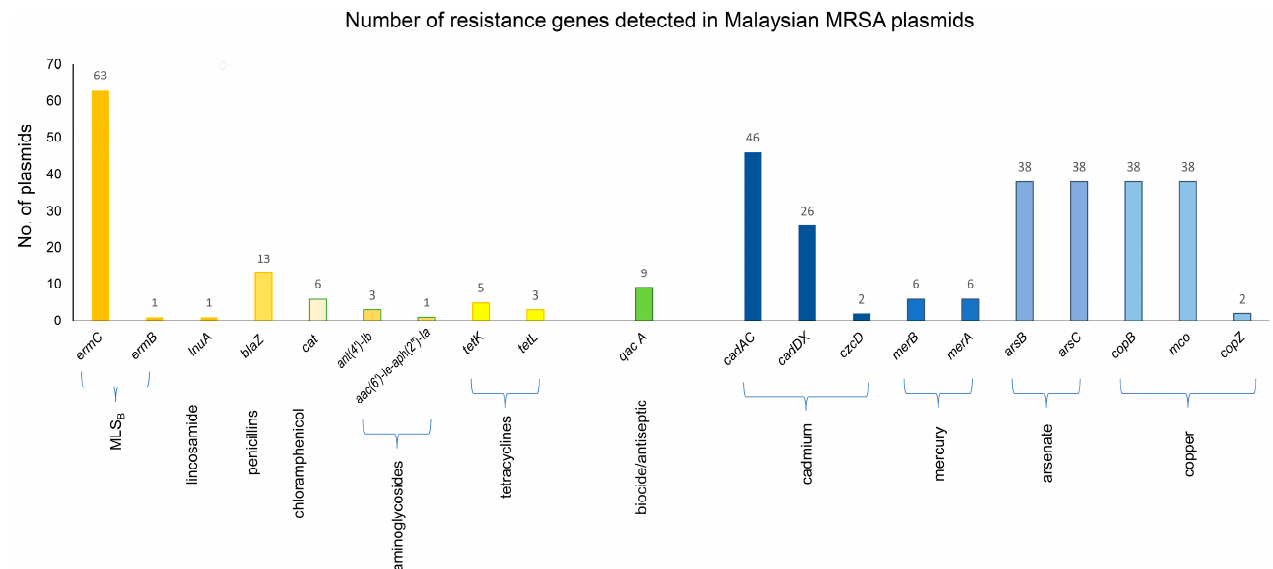
Figure 7. Carriage of antimicrobial, heavy metal, and biocide/antiseptic resistance genes in the Malaysian MRSA plasmids. The category of genes that were detected is categorized as follows: (1) antimicrobial resistance genes (indicated as different shades of yellow to orange bars), i.e., ermC and ermB , MLS B resistance genes; blaZ , penicillin resistance gene; tetL and tetK , tetracycline resistance genes; cat , chloramphenicol resistance gene; aac(6 ′ )-Ie-aph(2 ″ )-Ia (also designated aacA-aphD ) and ant(4 ′ )-Ib (also designated aadD ), aminoglycoside resistance genes; lnuA , lincosamide resistance gene; mupA , mupirocin resistance gene; (2) biocide/antiseptic resistance gene (indicated as a green bar), i.e., qacA , quaternary ammonium compounds resistance gene; (3) heavy metal resistance genes (indicated as di ff erent shades of blue bars), i.e., cadAC , cadDX and czcD , cadmium resistance genes; merA and merB , mercury resistance genes; arsB and arsC , arsenate resistance genes; and mco , copB and copZ , copper resistance genes.